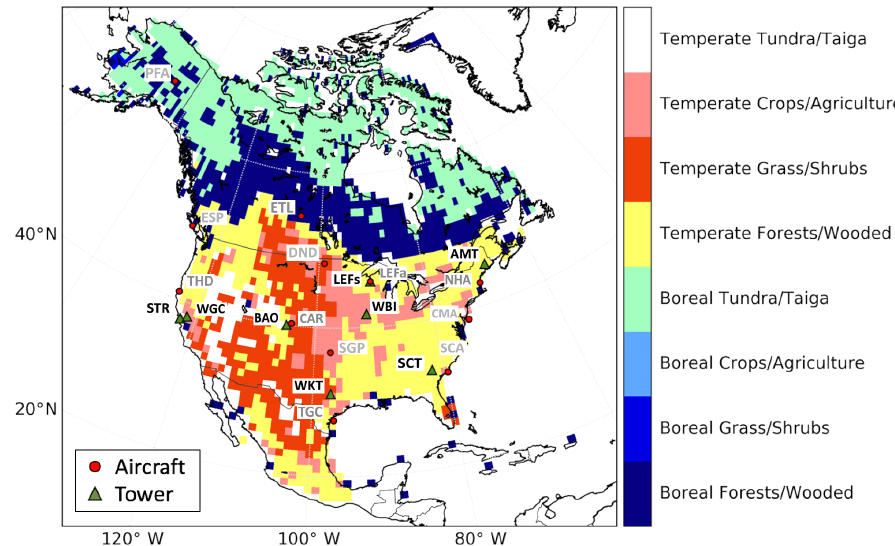
Figure 1. The model domain is shown together with the CO 2 observational sites from NOAA’s Global Greenhouse Gas Reference Network and the aggregated Olson ecosystem types. Eight tall tower sites are highlighted by green triangles with black site code labels, and 12 selected aircraft sites are highlighted by red dots with gray site code